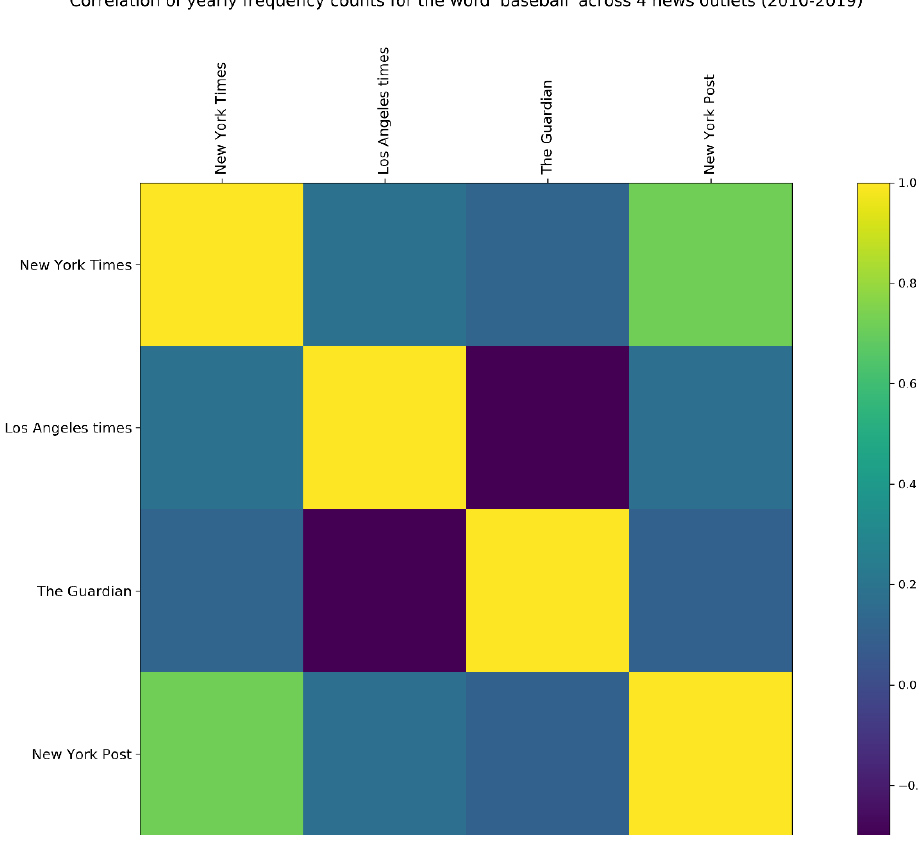
Fig. 3. Correlation matrix of frequency counts for the word baseball across 4 news